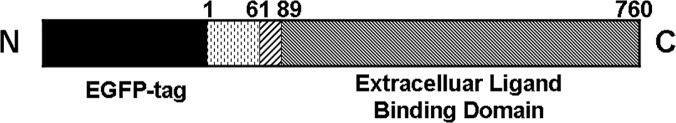
Schematic representation of the hTfR-EGFP chimera.TfR is a type II transmembrane glycoprotein found primarily as a homodimer consisting of identical monomers joined by two disulfide bonds. Each monomer (760 amino acids) consists of three major domains as follows: a large glycosylated extracellular C-terminal domain (amino acids 90–760) involved in ligand binding, a single-pass transmembrane domain (amino acids 62–89), and a short intracellular N-terminal domain (amino acids 1–61). The EGFP moiety is fused to the amino terminus of hTfR.